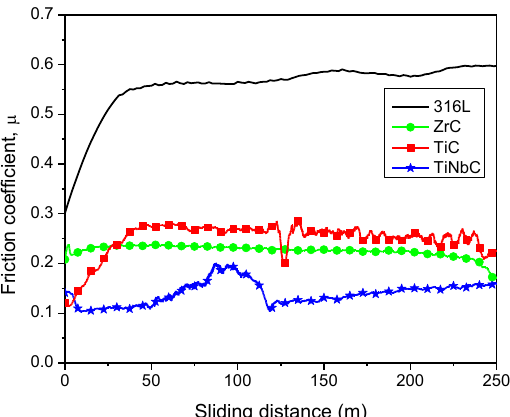
Figure 7. Evolution of the friction coefficients vs. sliding distance in 0.9% NaCl at 37 ± 0.5 ° C of the coated and uncoated 316L steel.